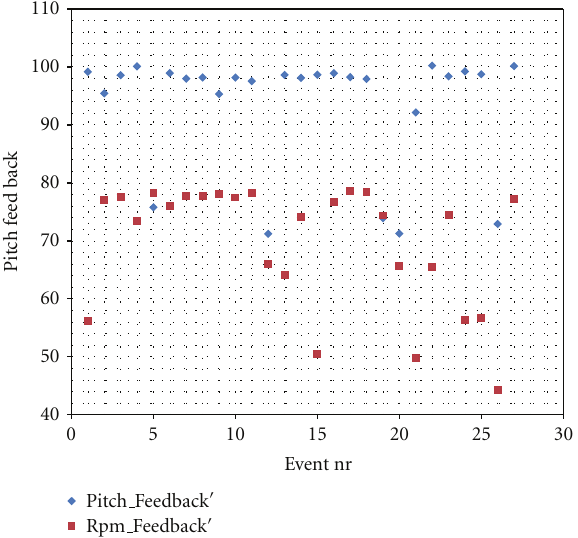
Figure 26: Propeller pitch and rpm feedback during the events— starboard unit.